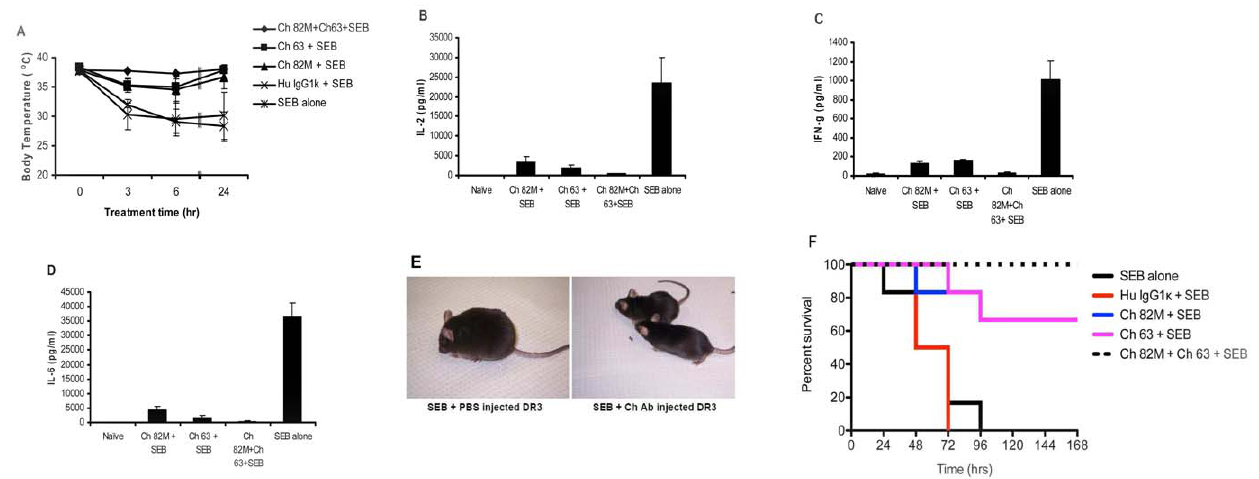
Figure 1. Chimeric anti-SEB 82 M and 63 synergistically protect HLA-DR3 mice from the toxic effects of SEB. ( A ) Protection against SEB- induced hypothermia. Age-matched HLA-DR3 transgenic mice were injected with the following: Ch 82 M + Ch 63 + SEB ( ¤ ), 500 m g chimeric 82 M + 500 m g chimeric 63 + 50 m g SEB; Ch 63 + SEB ( & ), 1 mg chimeric 63 + 50 m g SEB; Ch 82 M + SEB ( m ),1 mg chimeric 82 M + 50 m g SEB; Hu IgG1 k + SEB ( 6 ), 1 mg human IgG1 k + 50 m g SEB; SEB alone (*); 50 m g SEB in PBS. Rectal temperatures were recorded at the indicated time points. Error bars